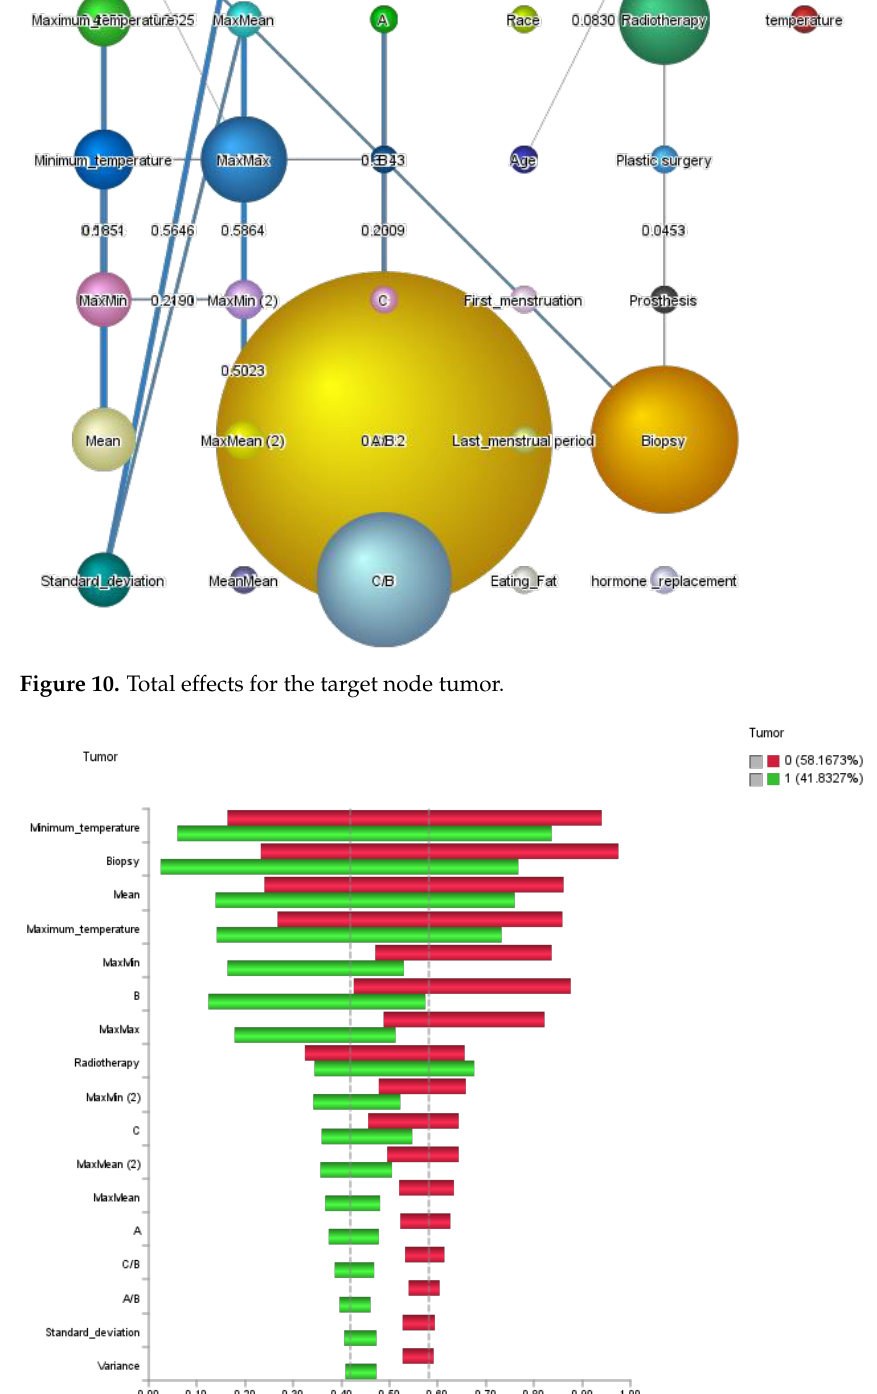
Figure 11. Tornado effects (conditional probabilities) for the target variable “tumor”.